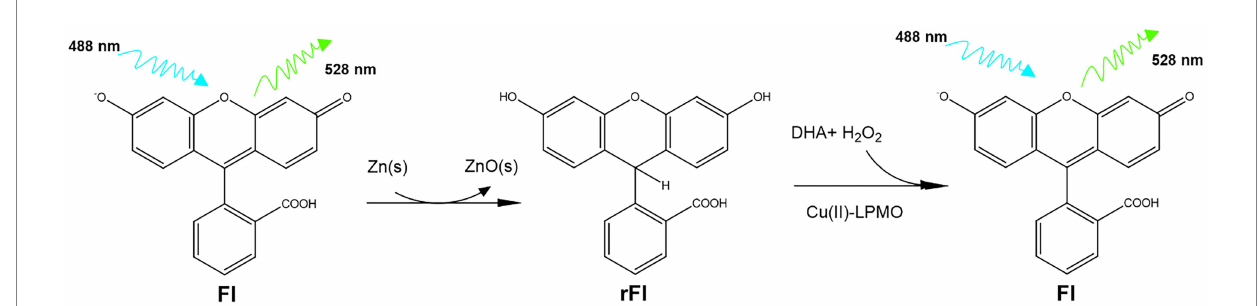
FIGURE 1 Reaction scheme for the interconversion of Fl and rFl. First Fl is reduced by boiling in NaOH with zinc powder. Residual zinc and zinc oxide is removed by filtration and the resulting rFl can then be re-oxidized by the action of